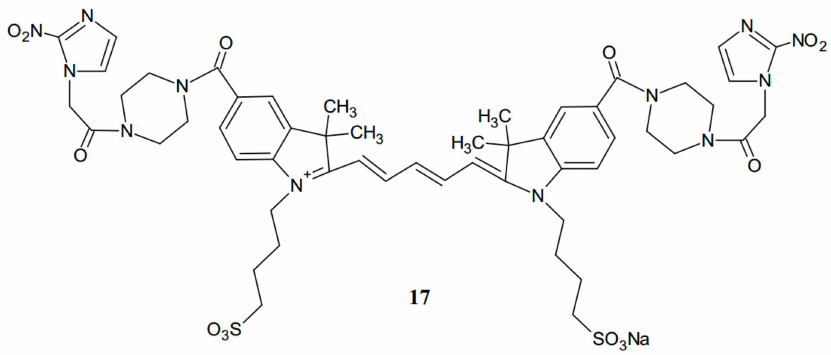
Figure 9. The structure of the third-generation conjugate ( 17 ).